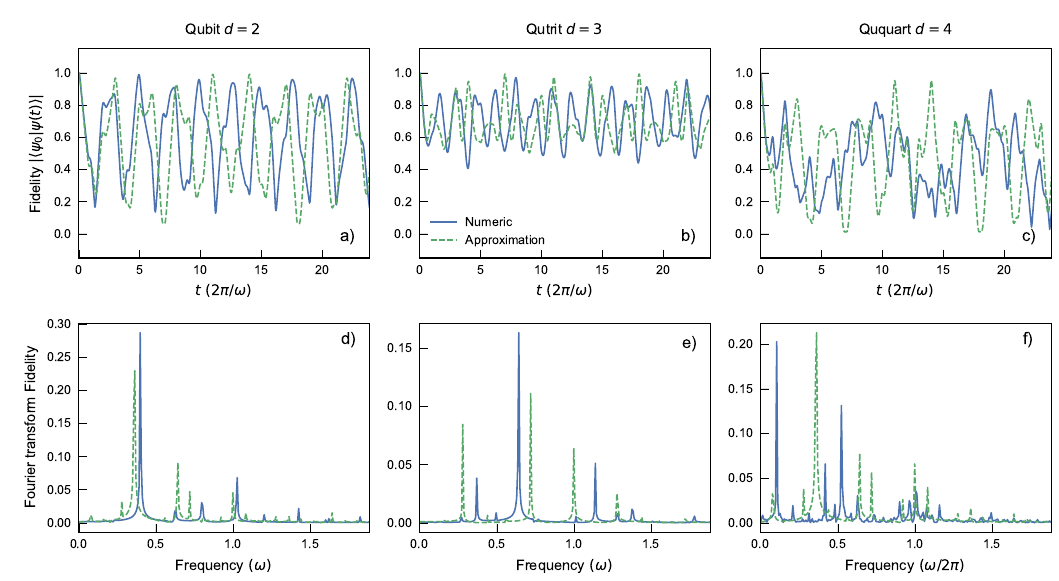
Figure 5: Fidelity dynamics after quenching the interaction strength. a)-b)-c) Fidelity between the initial state of the system and the instantaneous state for qubit (a), qutrit (b) and ququart (c) cases. The initial state is the ground state of the uncoupled system. The numerical expressions (solid) are compared to approximations (dashed) derived in the main text Eq. (18). d)-e) -f) Fast fourier transform of the fidelity evolution for d) qubit, e) qutrit, f) ququart. Parameters are Ω = g = 0.3 ω and g 1 2